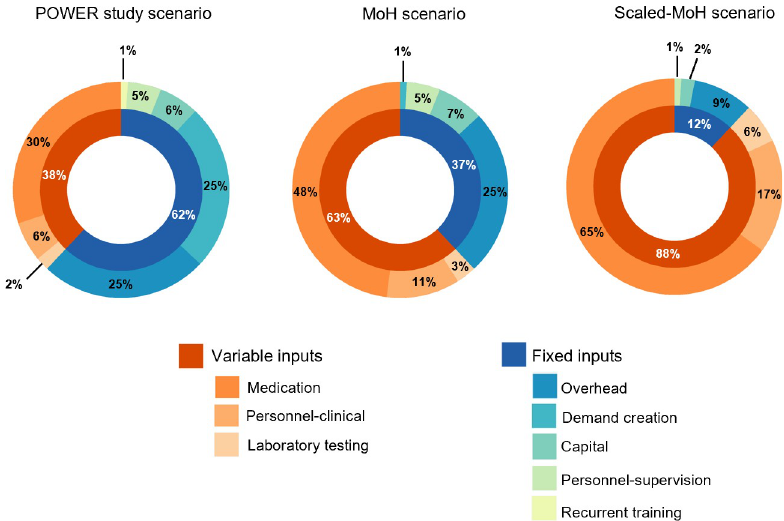
Fig 1. Proportion of total annual cost (2019 USD) by input type. Only proportions > 0.5% are presented. In the Ministry of Health scenario, recurrent training contributed 0.02%. In the Scaled Ministry of Health scenario, demand creation and recurrent training contributed 0.15% and 0.01%, respectively.